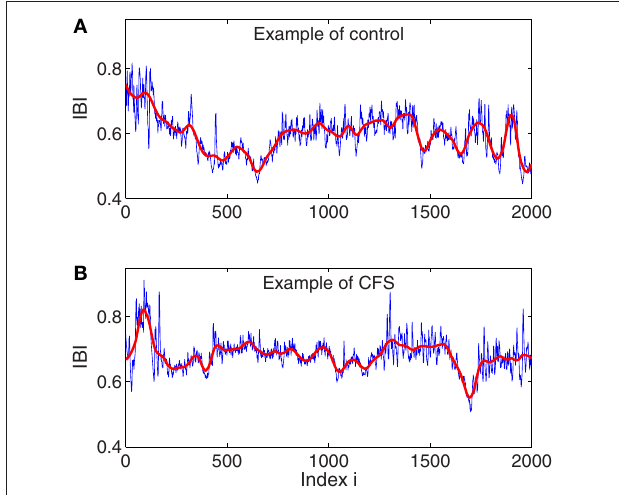
FIGURE 1 | Examples of IBI data for a control (A) and CFS (B) subject. The red curves are the trend signals obtained by the adaptive filter, which will be explained